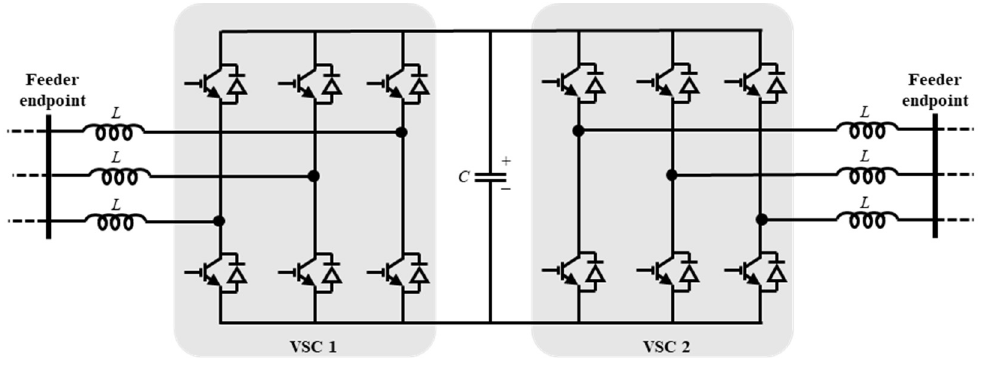
Figure 1. Soft open point configuration.